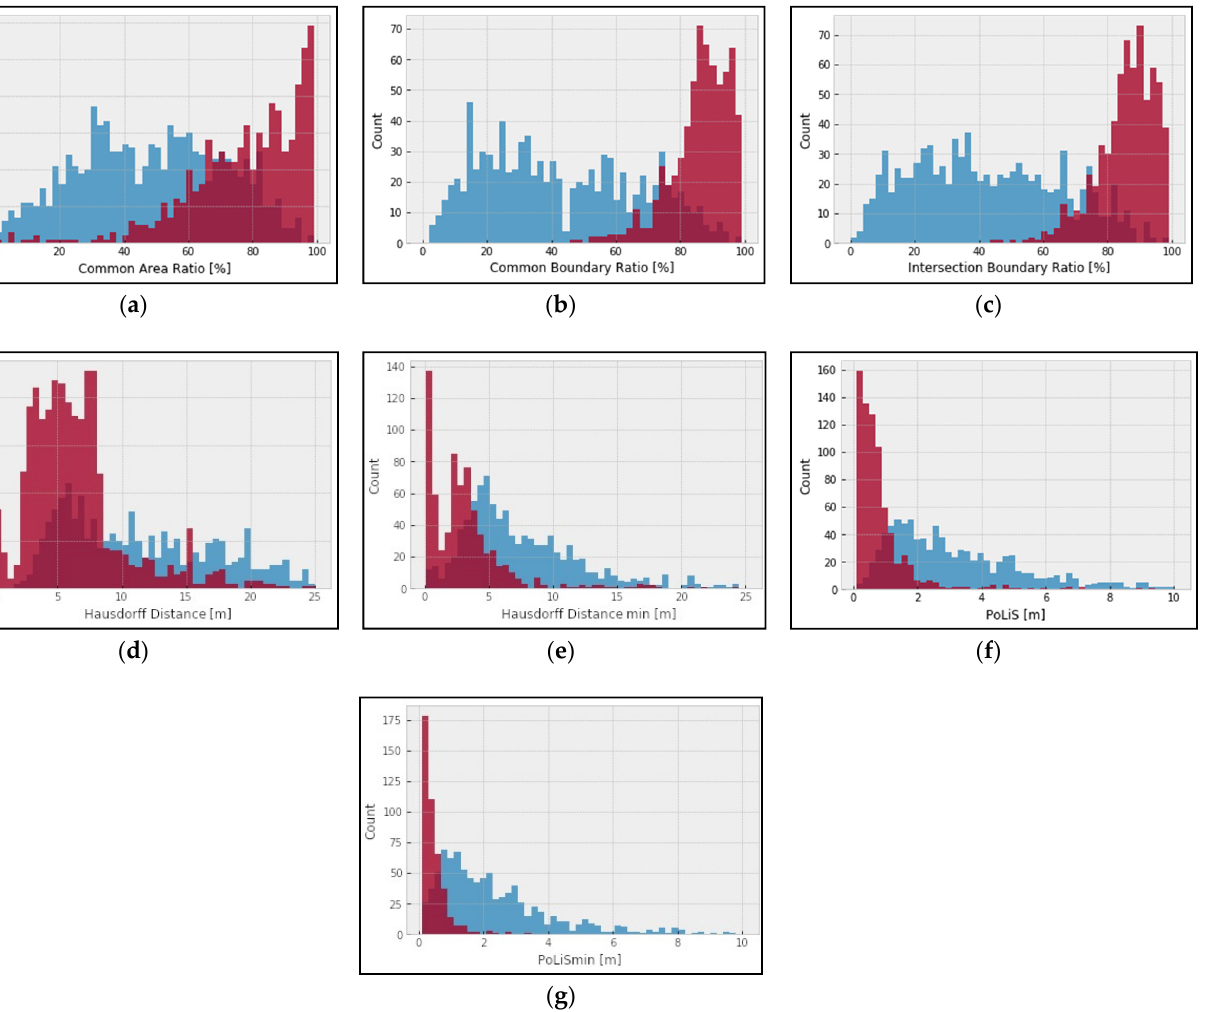
Figure 9. Histograms of the investigated matching methods: blue bars indicate modified buildings, red bars are replaced buildings, and dark red bars are the overlay of blue and red bars; ( a ) Common Area Ratio ( CAR ); ( b ) Common Boundary Ratio ( CBR ); ( c ) Intersection Boundary Ratio ( IBR ); ( d ) Hausdorff Distance; ( e ) Minimum function of Hausdorff Distance ( HDDmin ); ( f ) Polygon and Line Segments ( PoLiS ); ( g ) Minimum function of PoLiS ( PoLiSmin ).